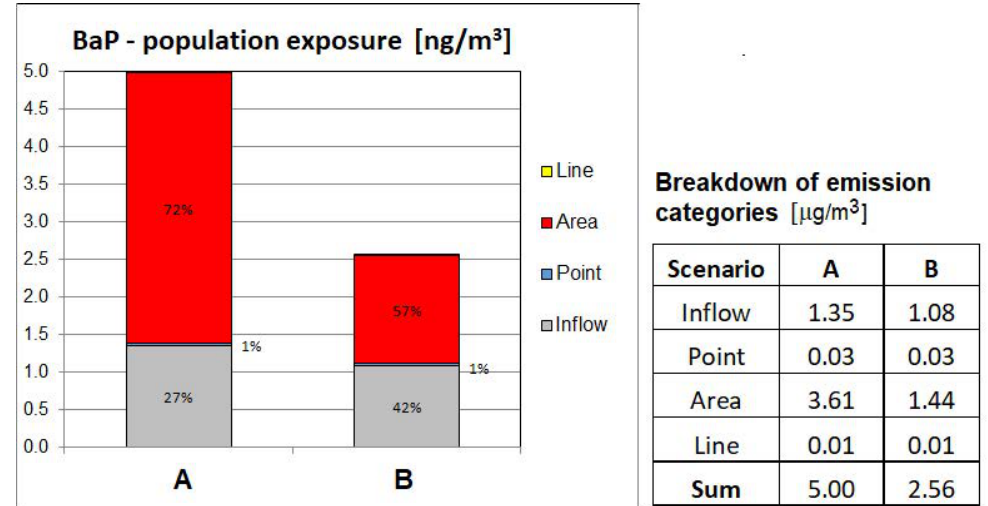
Figure 6. Modifications of BaP exposure.